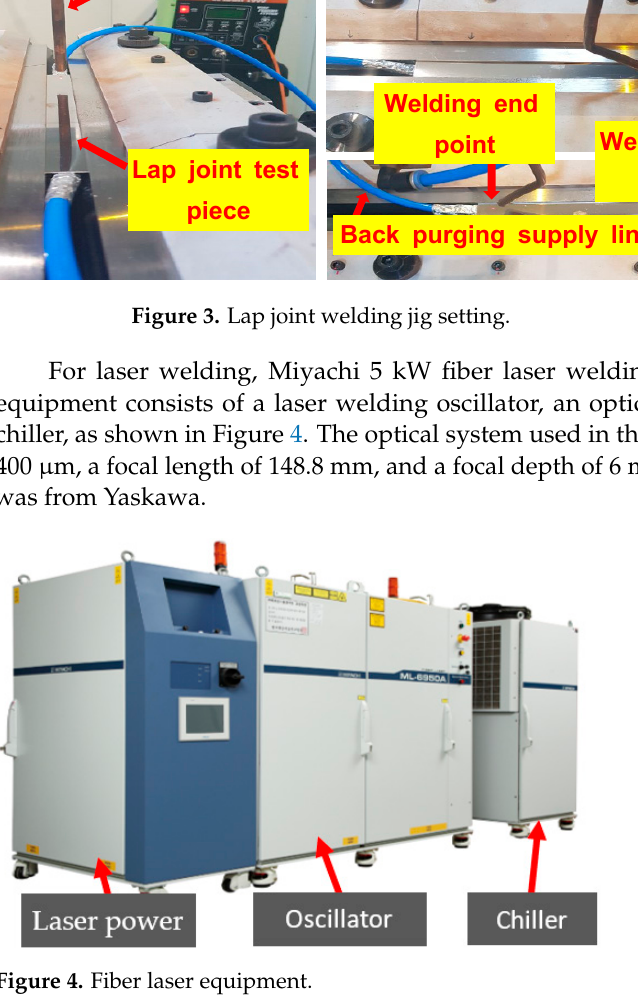
Figure 4. Fiber laser equipment.